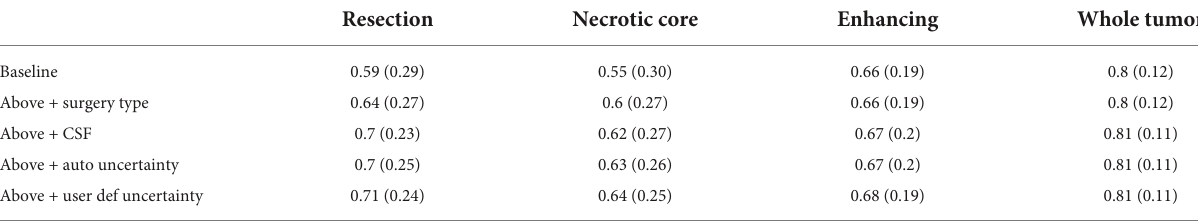
TABLE 1A A comparison of average Dice coefficient values for three glioblastoma multiforme (GBM) tissues and for the entire tumor segmented as one tissue.